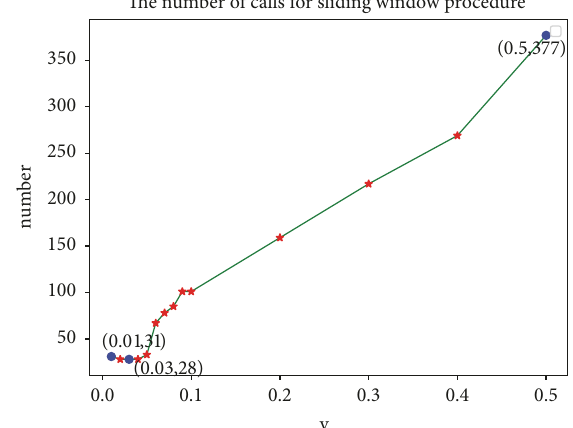
Figure 7: The number of calls for sliding window procedure is affected by the one-class SVM parameter V